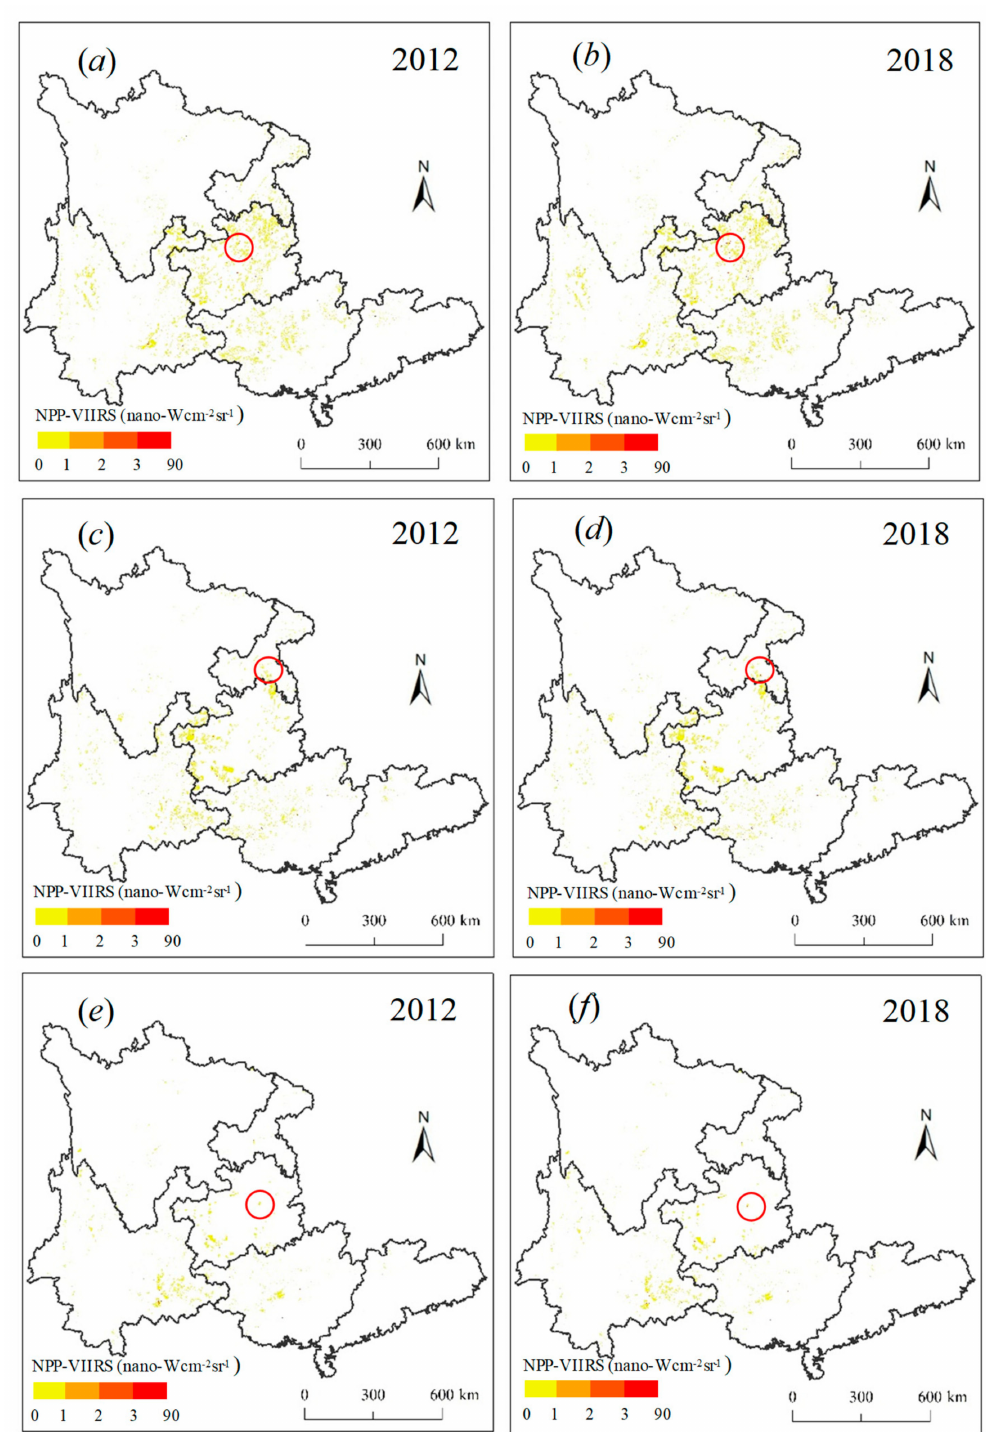
Figure 4. The corrected National Polar-orbiting Partnership (NPP) Visible Infrared Imaging Radiometer Suite (VIIRS) data related to karst rocky desertification from 2012 to 2018. Note: ( a , b ) The corrected NPP-VIIIRS data related to the L areas; ( c , d ) The corrected NPP-VIIIRS data related to the M areas; ( e , f ) The corrected NPP-VIIIRS data related to the S areas. L represents slight karst rocky desertification; M represents moderate karst rocky desertification; and S represents severe karst rocky